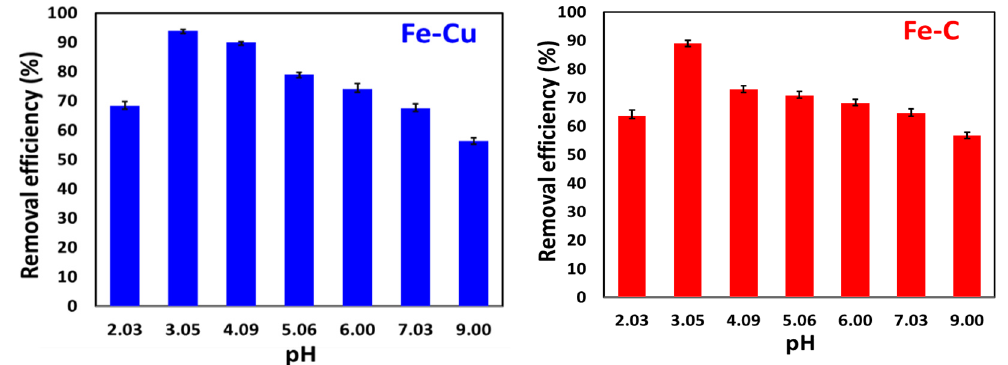
Figure 2. Effect of initial pH on CIP removal under Fe-Cu and Fe-C treatment.